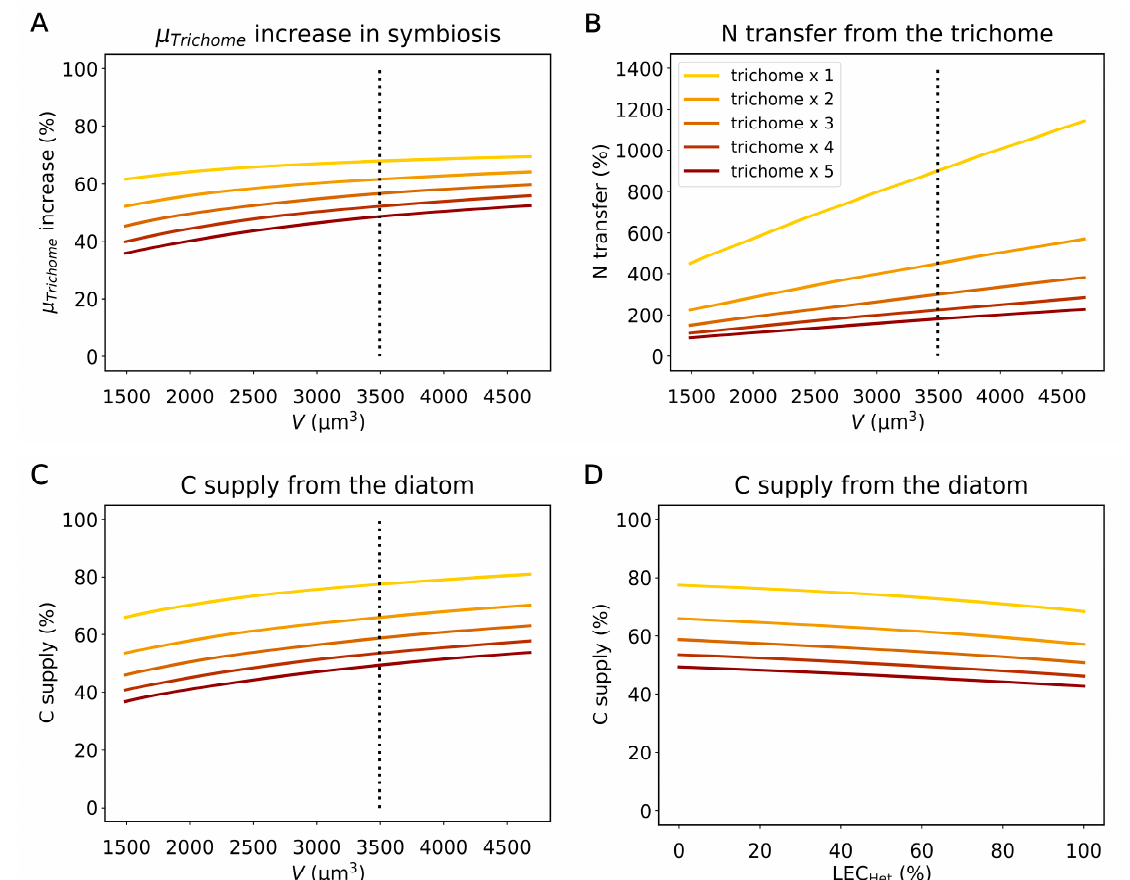
Figure 5. Simulated influences of the diatom volume ( V ) and number of the trichomes per diatom on N and C exchanges and the impact of light energy supply in heterocysts for sensitivity tests. ( A ) Increase in the (nutrient replete) growth rate of the trichomes ( µ Trichome ) relative to that for the trichome without symbiosis. ( B ) N transfer from the trichome to diatom relative to the N requirement for the trichome for various diatom sizes and number of the trichomes; 100% means that the amount of N transfer equals the requirement for the growth of the trichomes. ( C ) C supply from the diatom relative to the total C requirement of the trichome. Dotted lines indicate the averaged volume based on the observations after removing the two highest outliers [6]. ( D ) The impact of light energy contribution in heterocysts (LEC Het ) on C supply from the diatom relative to the total C requirement of the trichome. LEC Het indicates the fraction of energy requirements for N 2 fixation that is covered by light harvesting in heterocysts. For example, 100% means no fixed C requirement for energy production for N 2 fixation. We note that this energy requirement di ff ers from the electron requirement for N 2 fixation, which may not be covered by the light harvesting due to a lack of active Photosystem II [58]. The legend in (B) applies to all the panels. Trichome × n indicates n trichome per a diatom